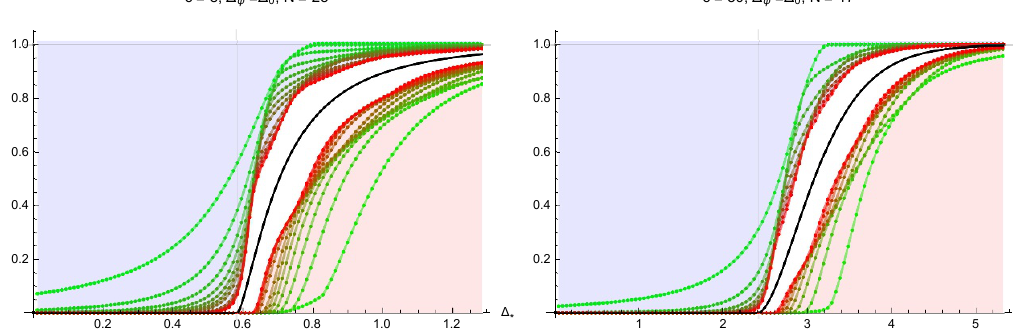
Figure 15 . Upper and lower bounds on the spectral function from linear functionals in the reduced basis, assuming only scalar primaries and (cid:1) (cid:30) = c (cid:0) 1 for c = 8 (left) and c = 30 (right). The black 12 curve denotes the corresponding spectral function of Liouville